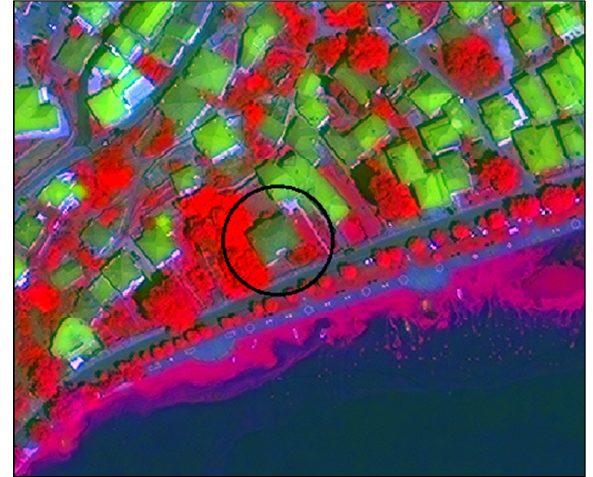
Figure 5. Skoutaris Mansion in the black circle (QuickBird subset image after decorrelation stretch).